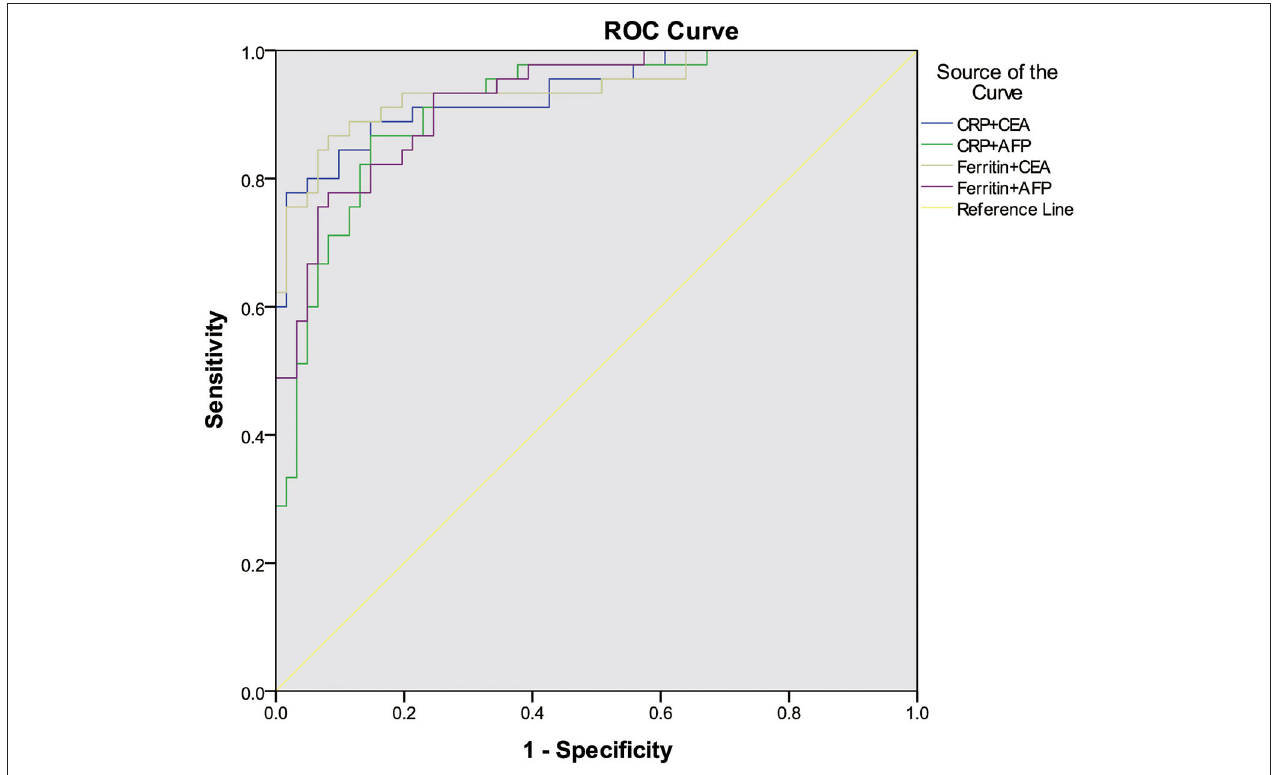
FIGURE 1 | The ROC curve analysis of different binary logistic regression models for the prediction of COVID-19 prognosis.